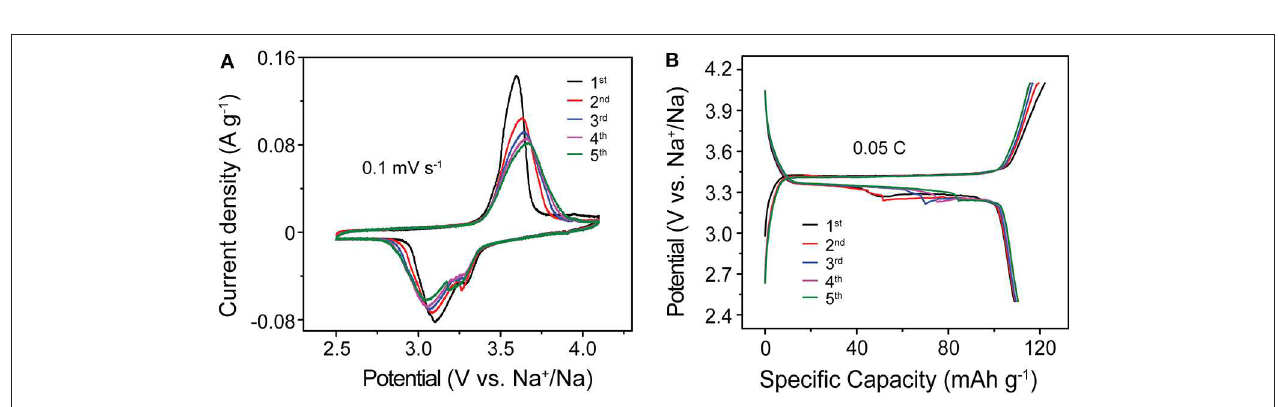
FIGURE 5 | (A) CV curves at the scan rate of 0.1mV s − 1 and (B) galvanostatic charge–discharge profiles at 0.5C of the NVPF/C/rGO.